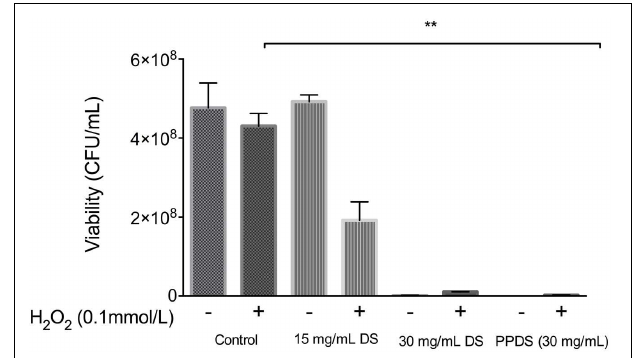
FIGURE 5 | Evaluation of the synergistic effect of DS and H 2 O 2 on cellular viability. Significant differences between treatment groups are indicated as ∗∗ p <